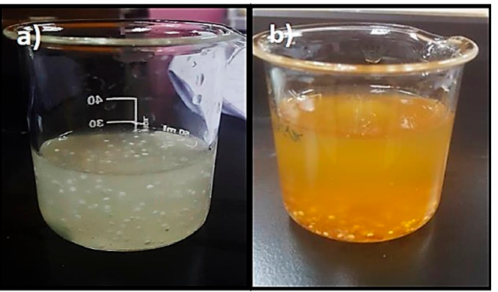
Figure 7. The appearance of jelly: ( a ) at 0 time point and ( b ) after being stored in packaging 1 in the accelerated chamber for 3 months.